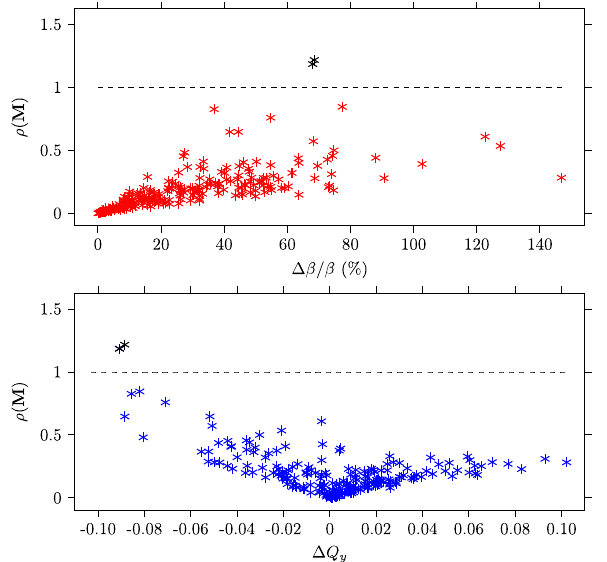
shift.FIG. 9. ρ ð M ð Δ β for beta beating produced by randomly β ÞÞ distributed field errors for an initial vertical tune Q Top: Versus beta beating. Bottom: Versus tune